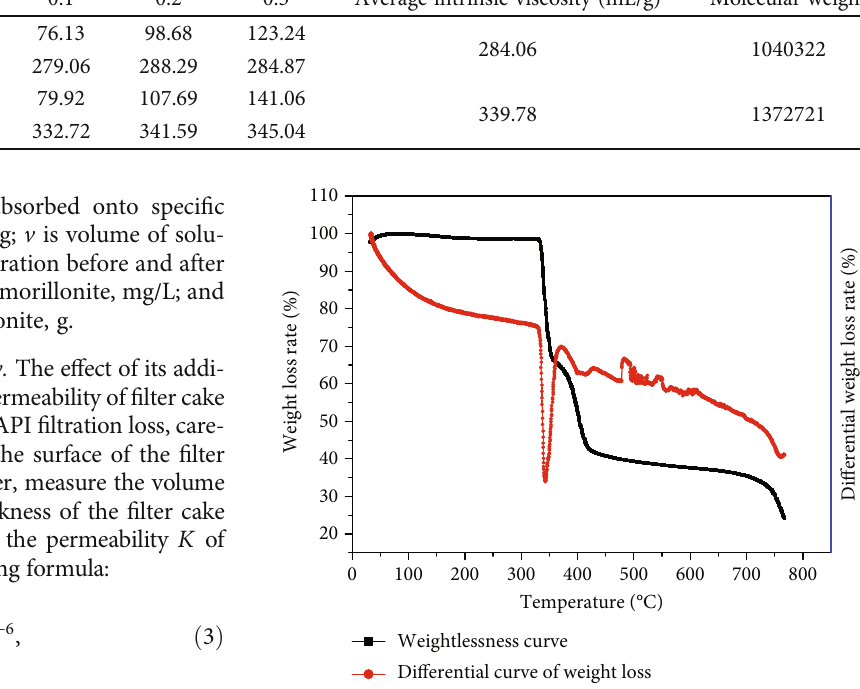
Figure 3: Curves of TG and DTA of HTRTP in nitrogen gas ambience.